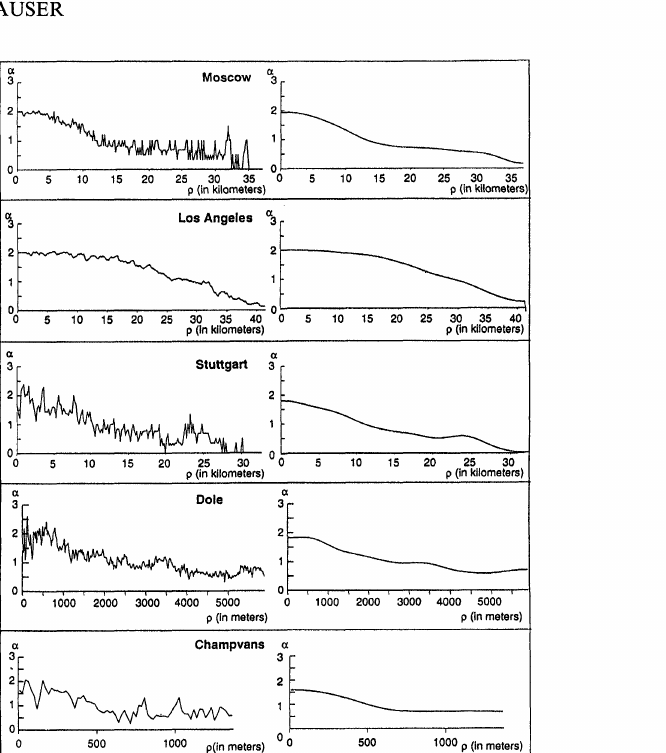
FIGURE 5 A comparison of the scaling behavior of ag- glomerations of different size: on the left the original curves, on the right the smoothed